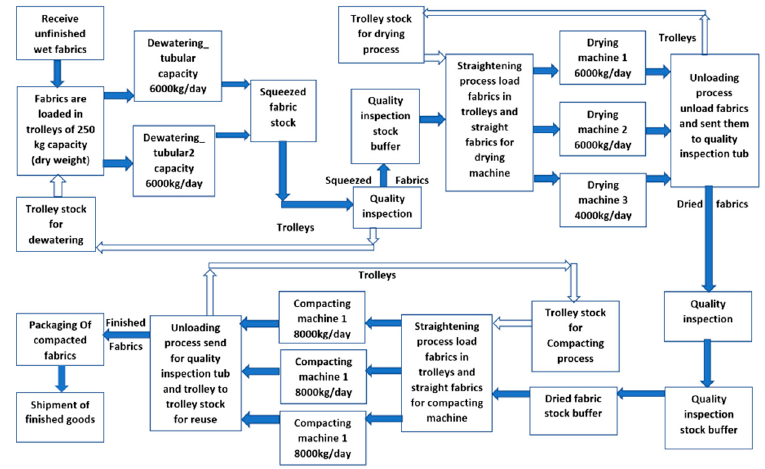
Figure 3. Process identification for tubular fabric production line.